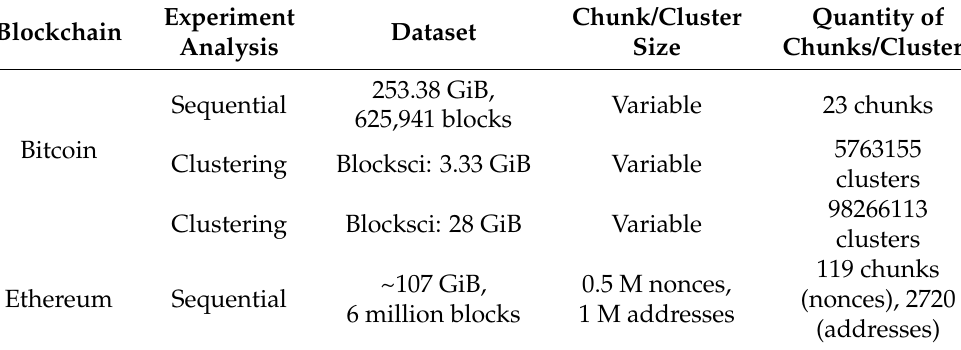
Table 3. Summary of the datasets manipulated in each